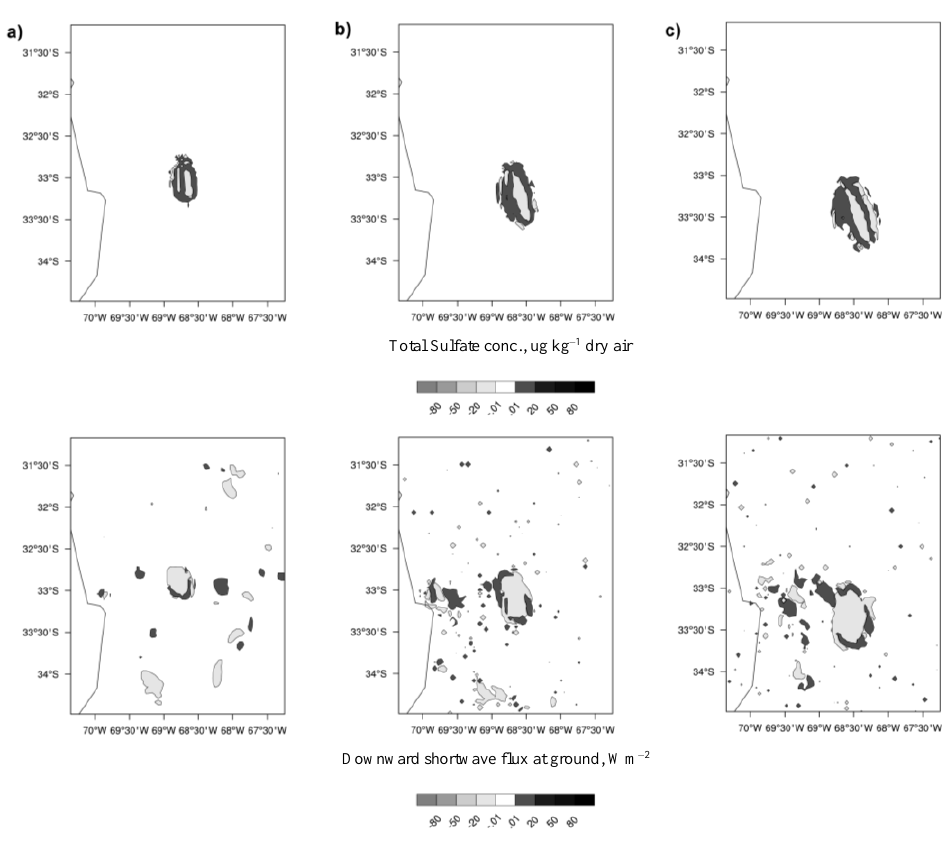
Fig. 12. Anomaly calculated as ID3 − ID4 for total (Aitken mode + Accumulation mode) SO 4 2 − concentration at 4 km a.s.l. (upper panel) and surface incident shortwave radiation on January 8, 2012 at: a) 9:00 LT; b) 10:00 LT; c) 11:00 LT. Fig. 13 exhibits the effects produced by sulfate aerosols on the radiative balance on January 8, 2012 at 12:00 LT. Table 2 shows that ID5 has the same configuration as ID1, but with a higher rate (1000 g s − 1 km − 2 injection). Through the ID5 − Test_Control difference, the image shows that ID5 produces a slightly higher aerosol concentration on surface than the aerosol concentration of the control test (< 1 µg kg − 1 dry air) (Fig. 13(a)), a slight reduction in surface temperature (Fig. 13(b)), a decrease of incoming surface shortwave radiation (Fig. 13(c)) and a loss of non-radiative sensible heat flux (Fig. 13(d)). In comparison to the ID1 rate of 30 g s − 1 km − 2 that barely modifies the surface temperature; the ID5 rate of 1000 g s − 1 km − 2 could achieve an average decrease of surface temperature of 0.5  C around Great Mendoza. Such non-radiative flux represents the loss or gain of surface heat by conduction, that is, through heat transfer between the lowest layers of the atmosphere and the